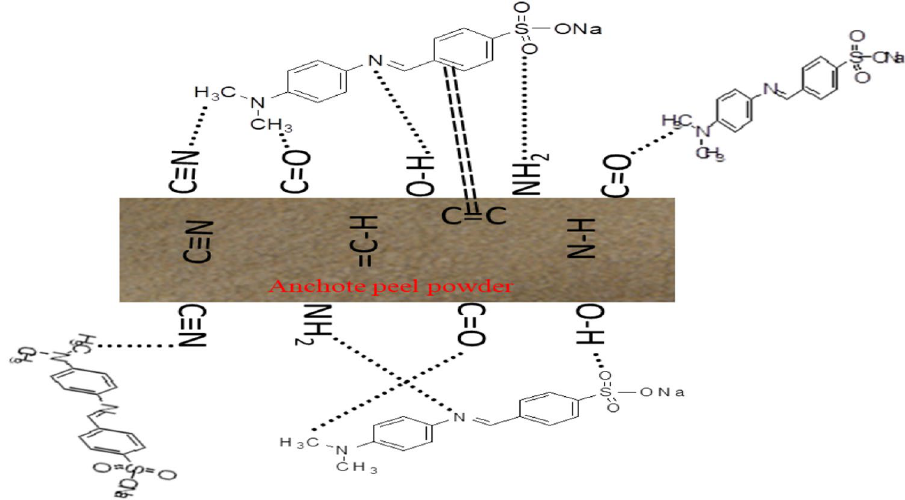
Fig. 9 Schematic of adsorption mechanism of MO adsorption onto Anchote peel powder